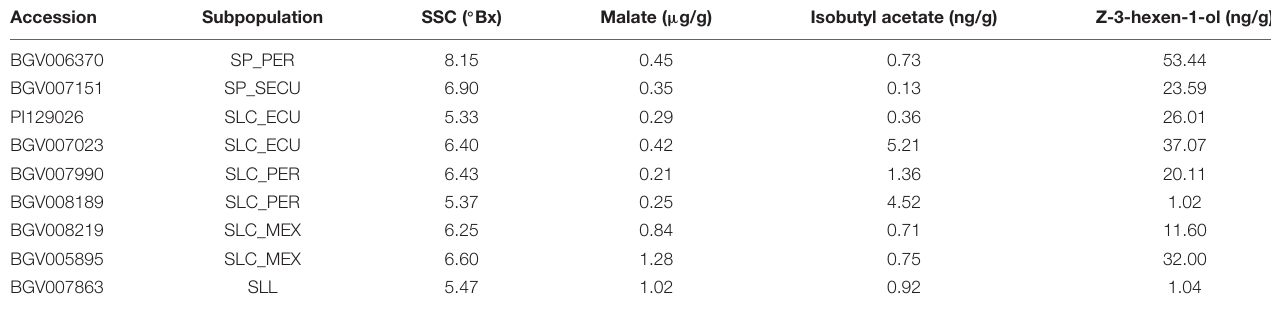
TABLE 2 | Accessions used for transcriptomic analysis and corresponding metabolite